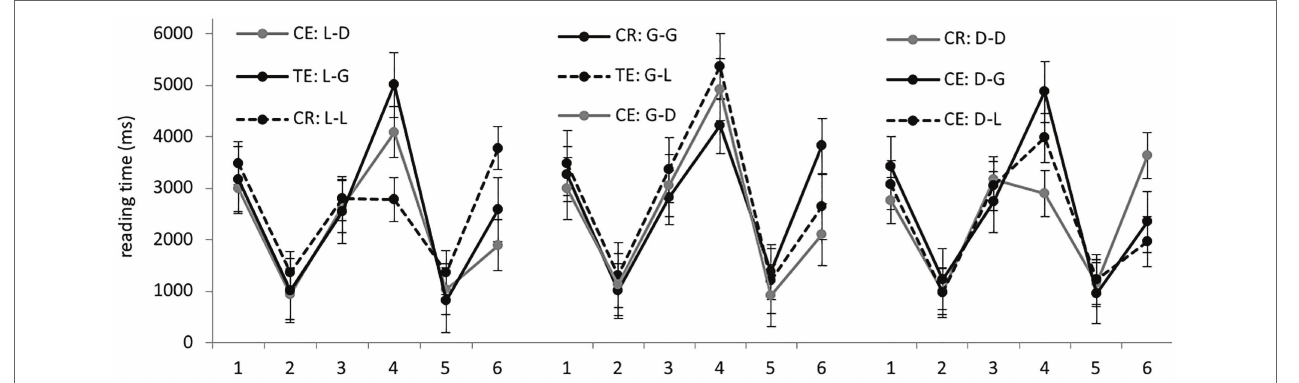
FIGURE 4 | Group 3: average RTs per region (in ms) in the nine experimental